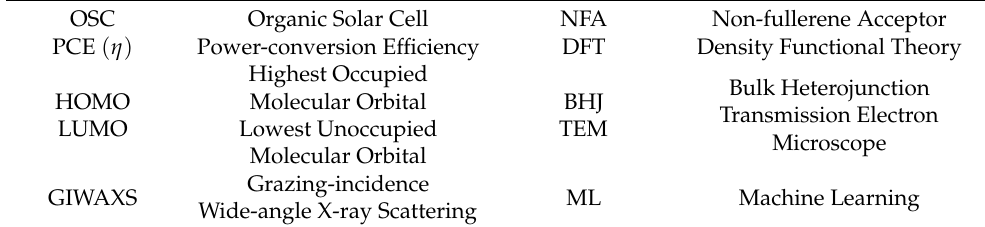
Bulk Heterojunction BHJ Transmission Electron TEM Microscope ML Machine